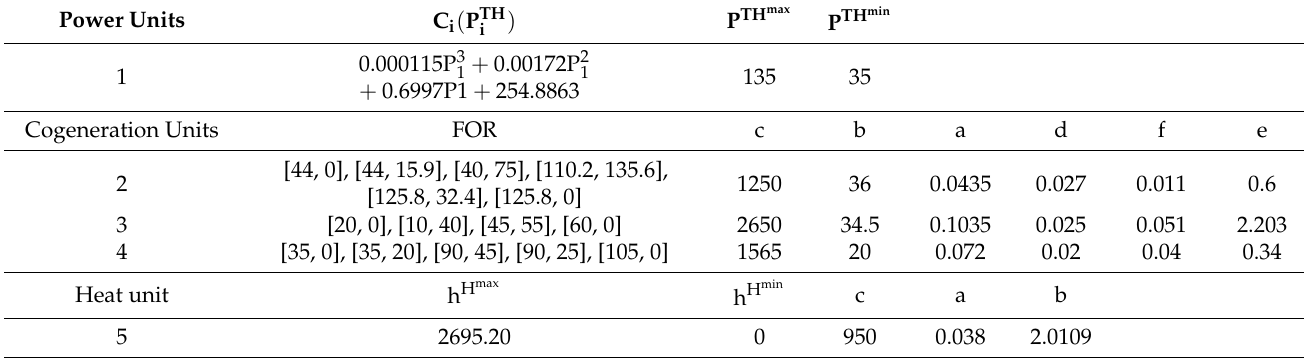
Table A1. Cost function parameters of the five-unit test system.